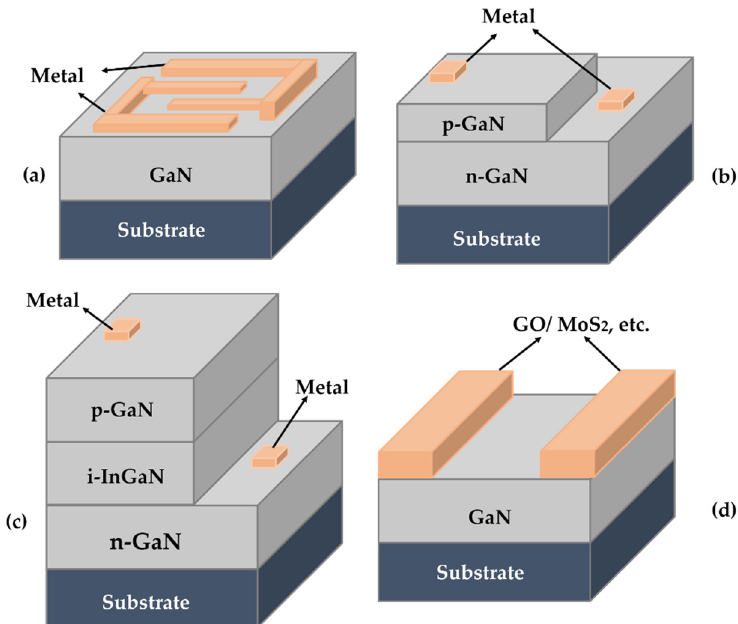
Figure 4. Schematic diagrams of non-polar GaN-based photodetectors with different designs: ( a ) MSM, ( b ) pn, ( c ) p-i-n, and ( d ) hybrid.